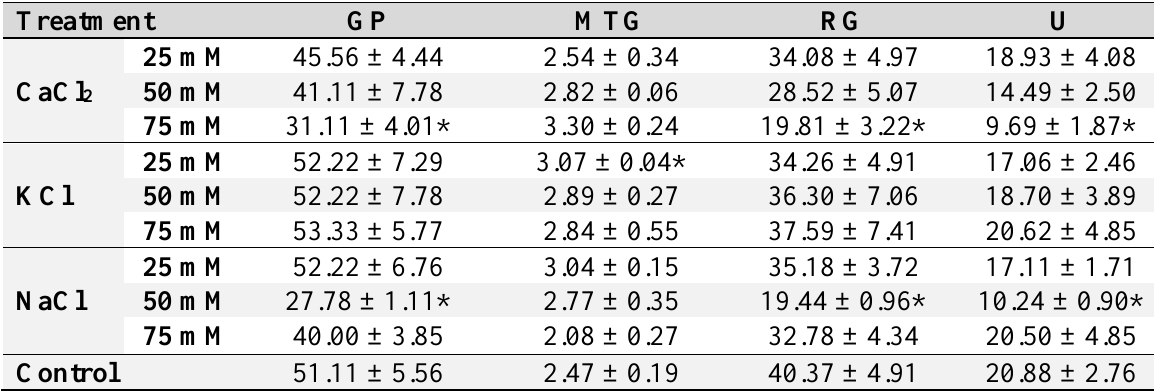
Table 1. Effect of different concentrations of CaCl on germination characteristics of Raphanus sativus L. (without